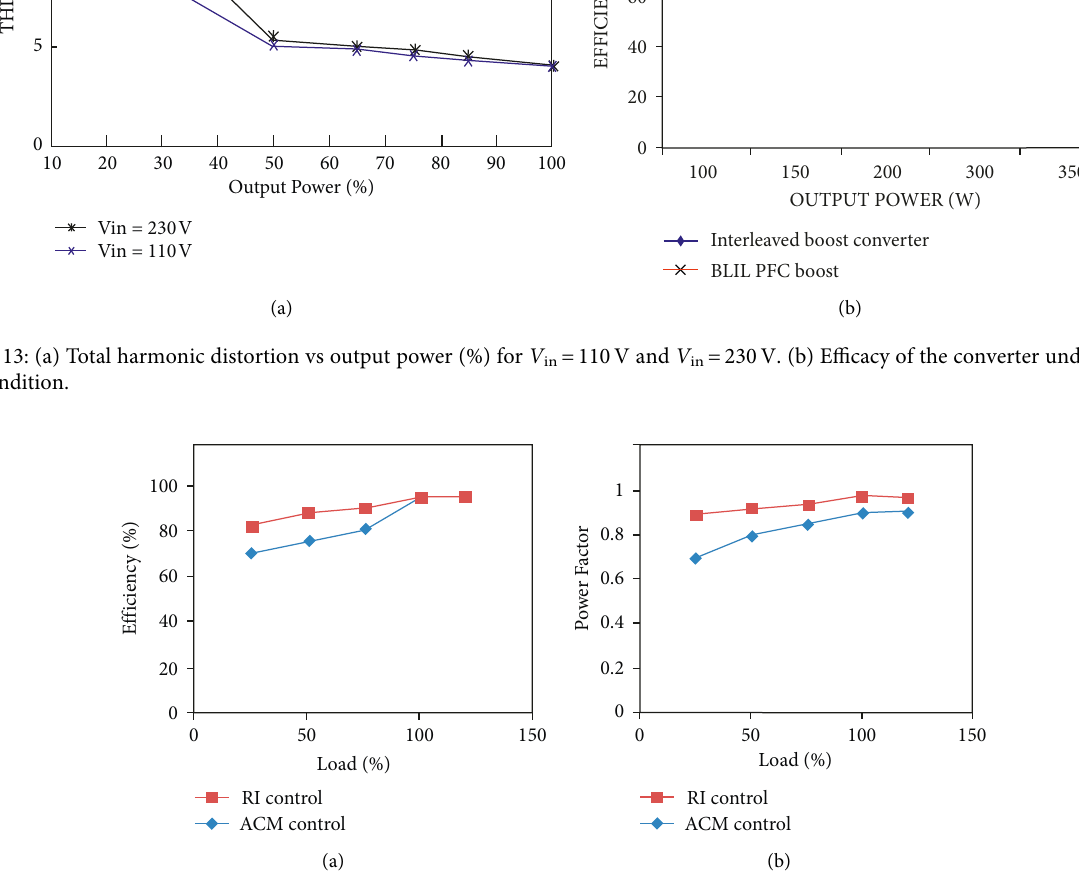
Figure 14: (a) Efficacy vs load power (%). (b) Power factor vs load (%).